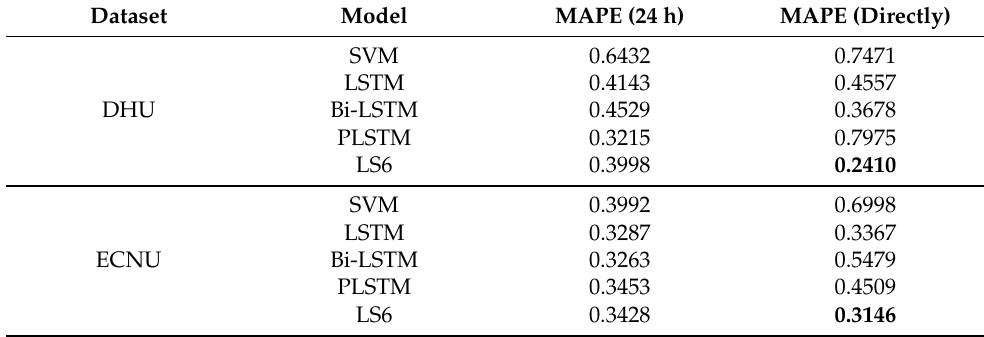
Table 6. Prediction performance of LS6 and baseline methods in different training